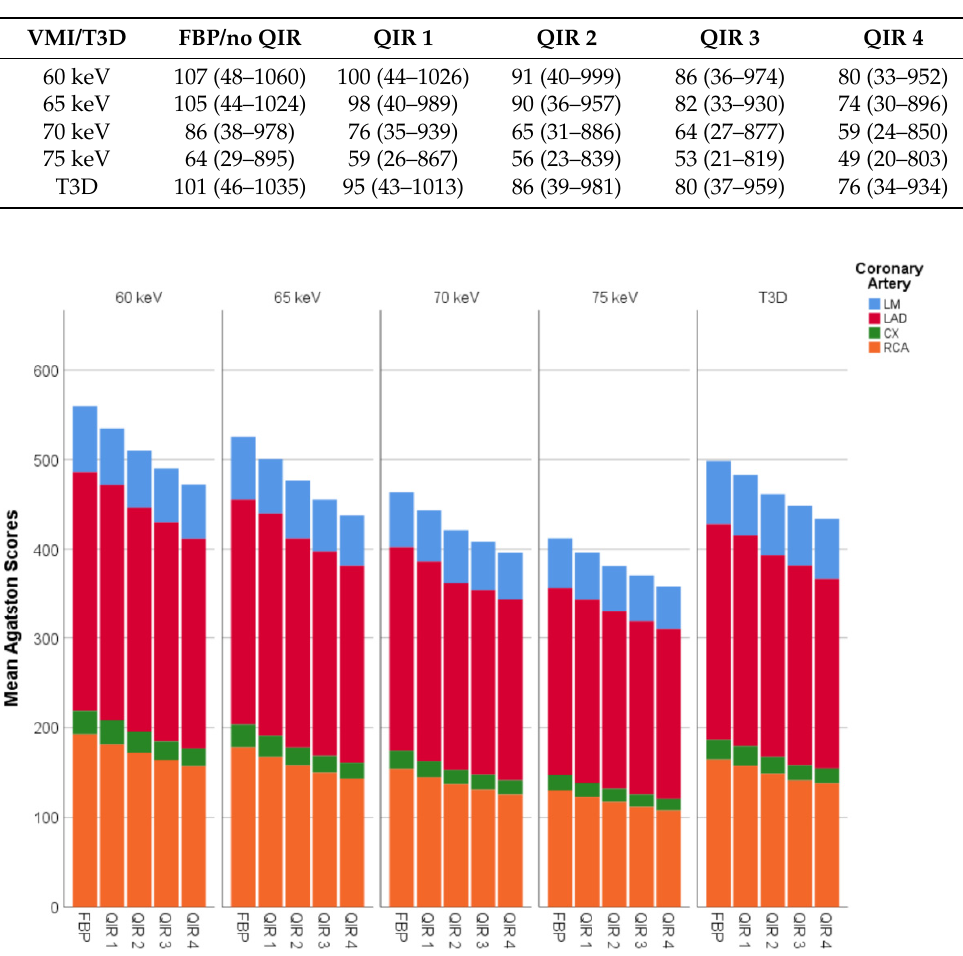
Table 2. Distribution of Agatston scores in the patients.